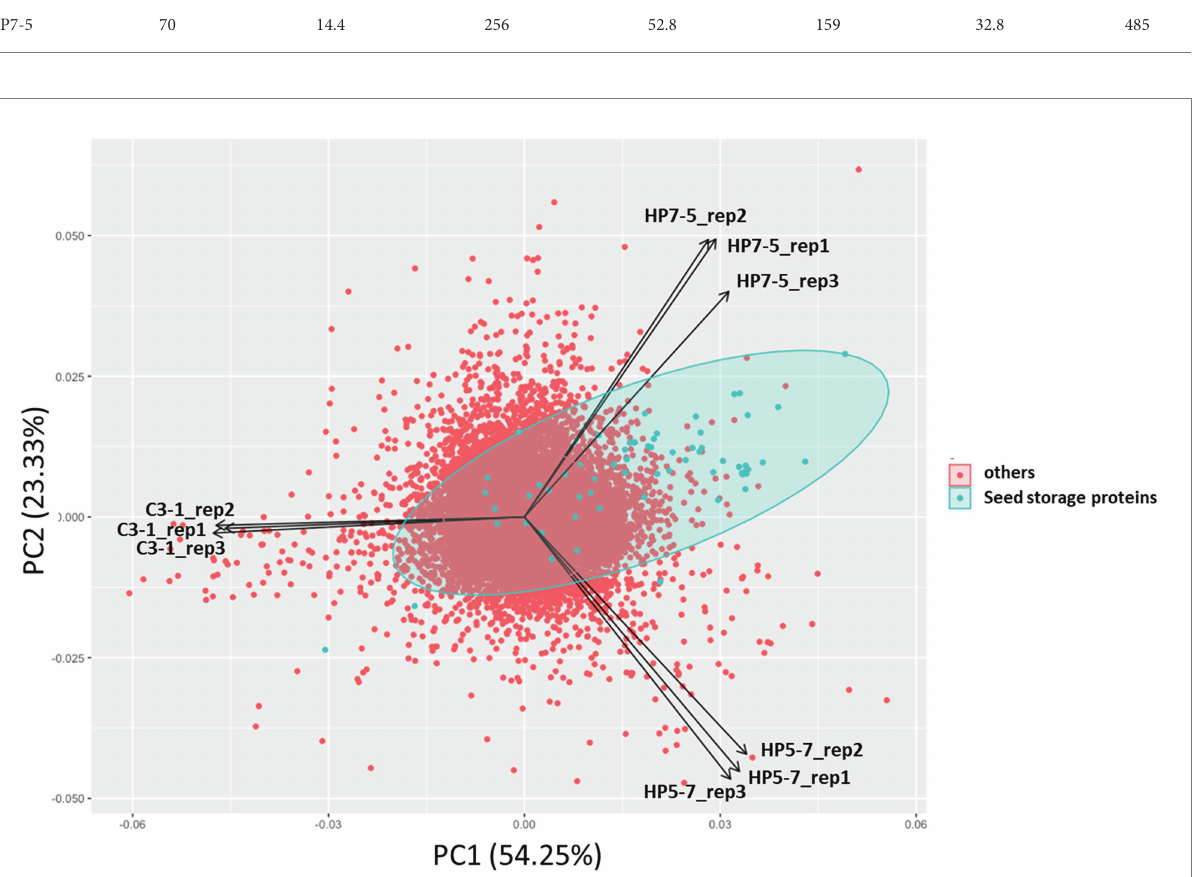
FIGURE 3 Results of principal component analysis (PCA) based on the expression levels of 37,871 genes. Principal component scores of seed storage protein genes are plotted as green